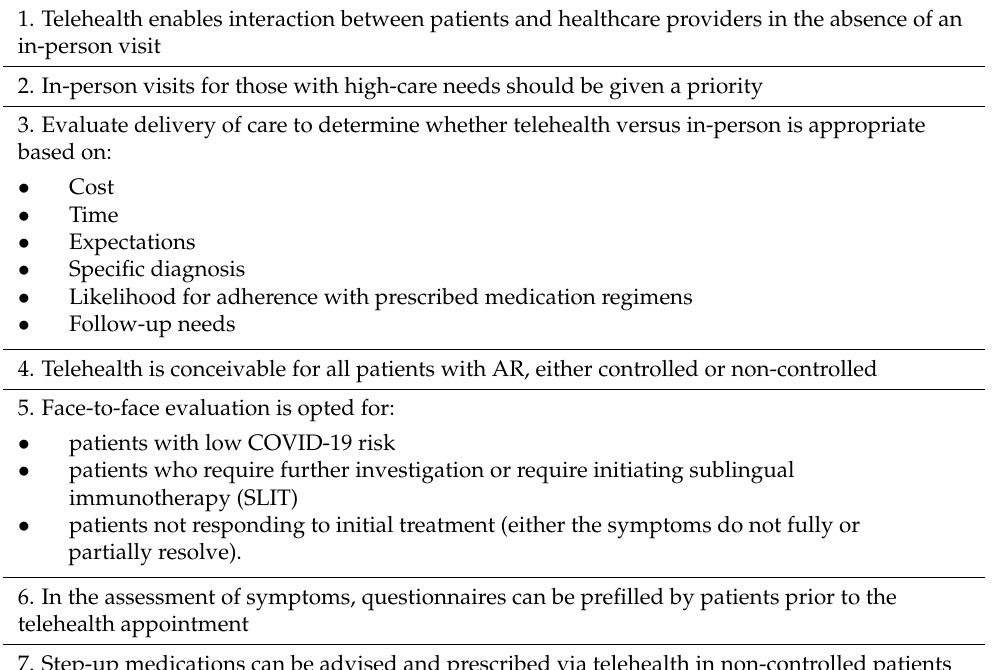
Table 1. Key considerations for telehealth use in patients with